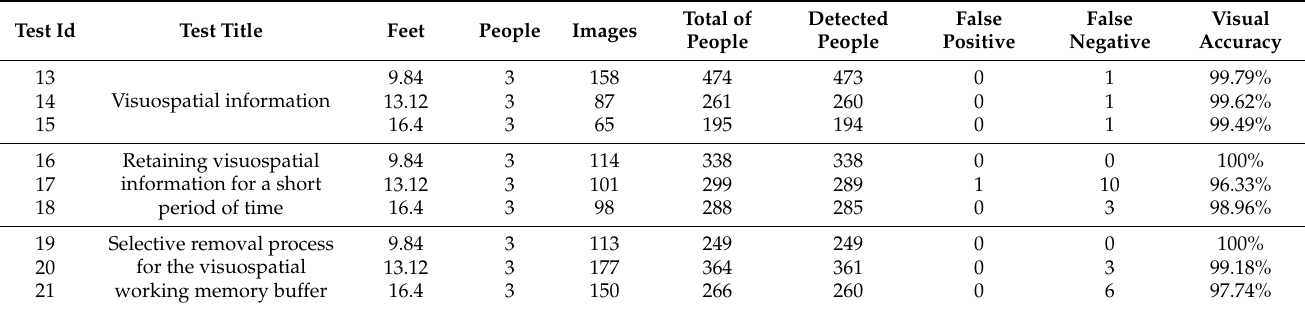
Table 6. Results of the second test scenario.